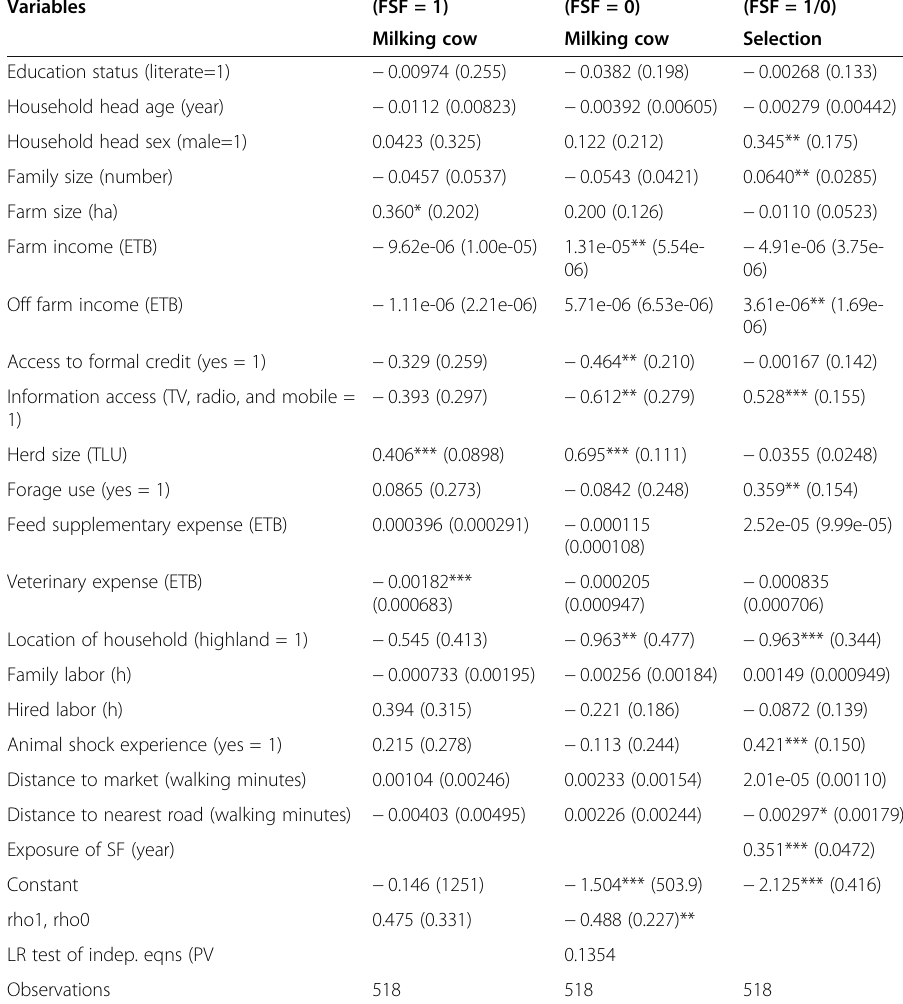
Table 4 Endogenous switching for FSF adoption and milking cows ownership